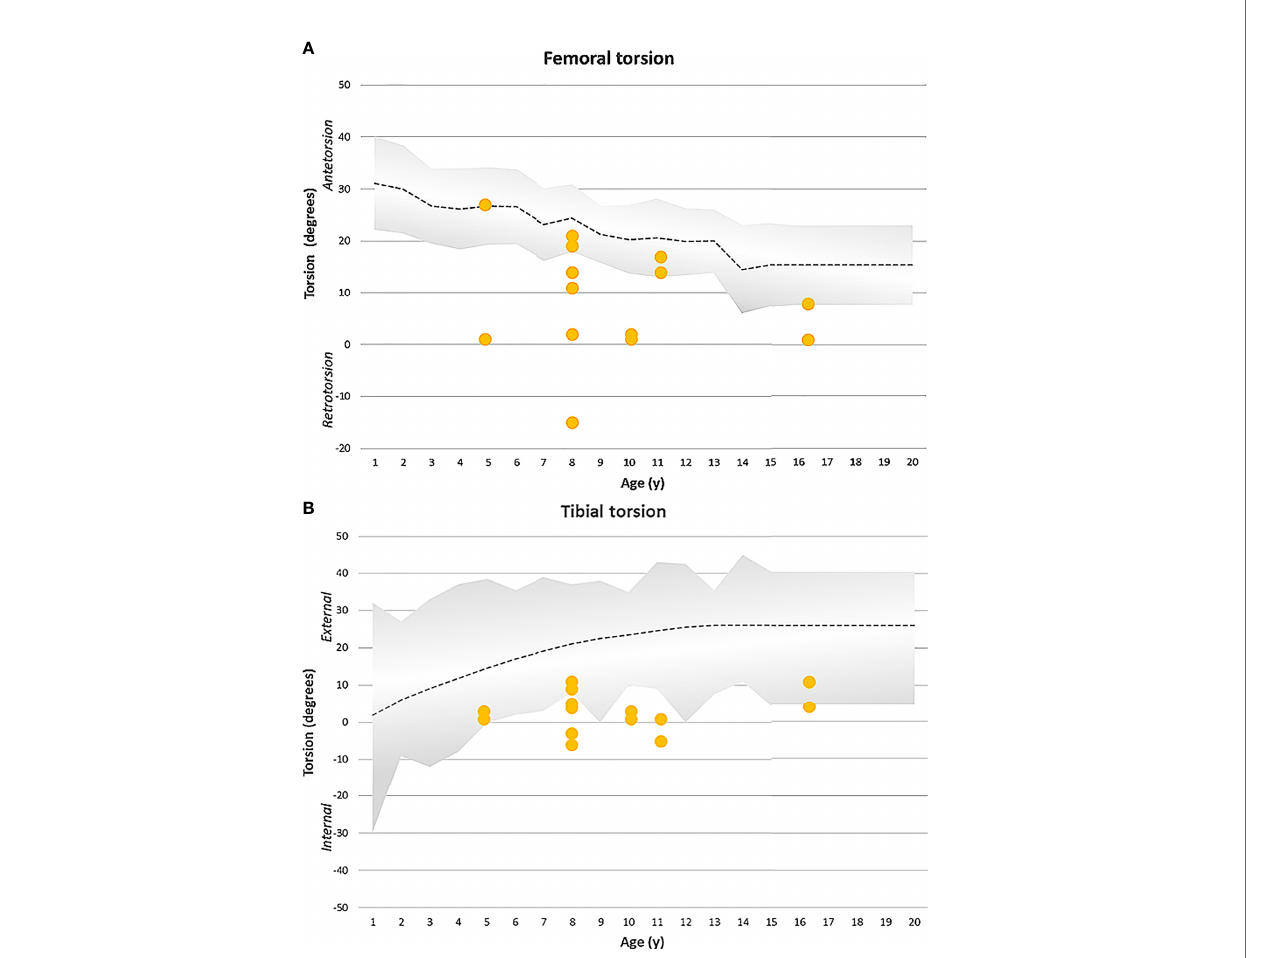
FIGURE 4 | (A) Femoral torsion (MRI measurement) observed in the XLH cohort (yellow dots represent each femur) with Burosumab therapy compared to the norm group (grey). 8/14 femora showed reduced antetorsion, respectively retrotorsion. Radiographic norm group values (+-1SD) were obtained from Fabry et al. (17). (B) Tibial torsion (MRI) was assessed in a XLH population undergoing Burosumab therapy (yellow dots represent each tibia). 9/14 legs showed reduced external tibial torsion. Clinical reference values (+-2SD) obtained by Staheli et al. (18) are shown by the grey